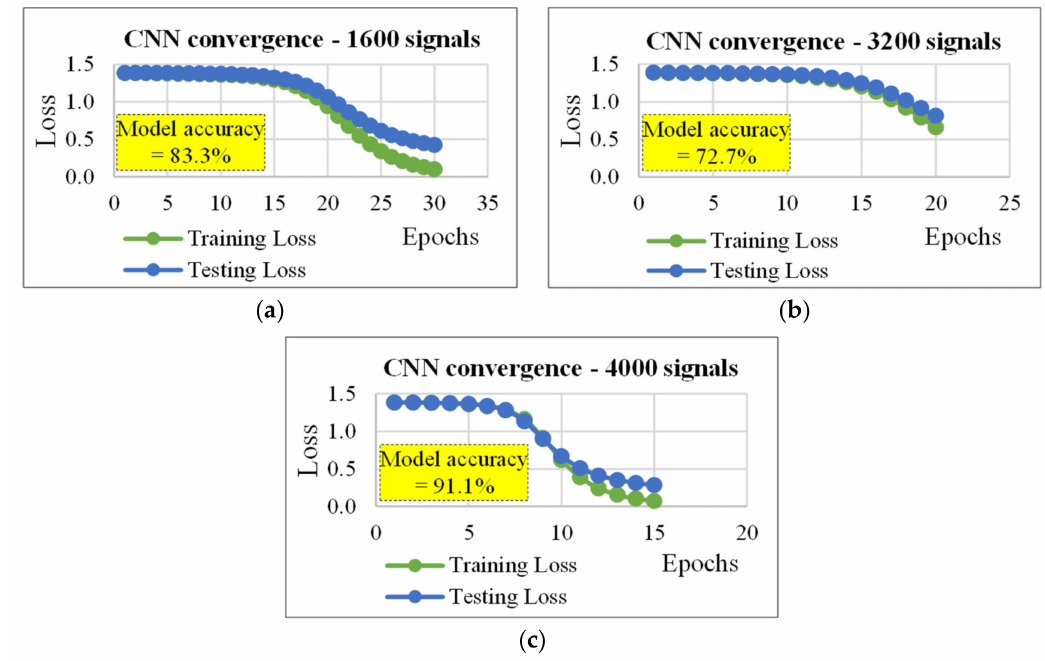
Figure 6. Convergence plots for the CNN (cf. Table 3, section “with same convolutional and pooling layers of Table 2”): ( a ) data set size (D) = 1600 signals, ( b ) D = 3200 signals, and ( c ) D = 4000 signals.